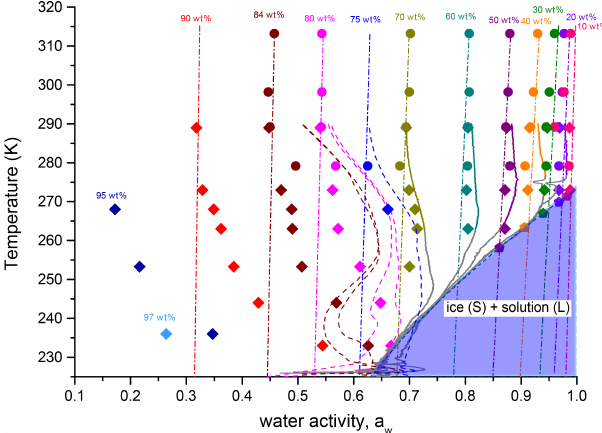
Figure 5. Experimental water activities vs. temperature for aque- ous M5 solutions. The solid and dashed curves are from the total gas phase pressure measurements. The coloured dashed curves (75– 84wt%) represent measurements for which the solution was not in a homogeneous liquid state but partly crystallised. The coloured portion of the solid curves represents the temperature range for which the measurements are considered reliable (grey elsewhere). Water activity data obtained from DSC measurements on the water- ice melting curve from Zobrist et al. (2008) are shown by solid pentagons. The solid circles show the data from bulk a w measure- ments with the water activity meter. The dash–dotted lines show the composition- and temperature-dependent a w parameterisation by Zobrist et al. (2008). The blue dashed line is the ice melting curve (Koop and Zobrist, 2009). The a w data from EDB measure- ments are represented by coloured